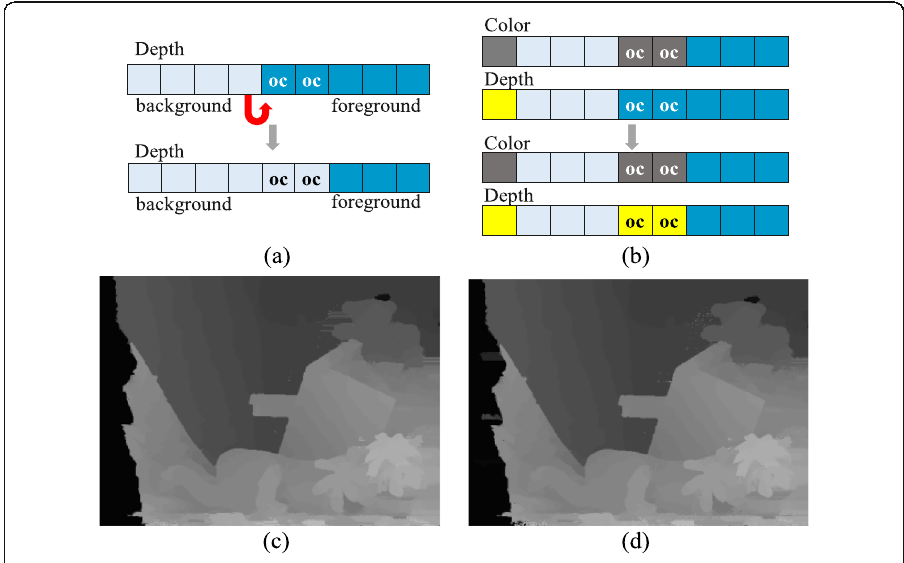
Fig. 12 Illustrations and results of the occlusion small-hole background filling methods. a Regular. b Matched-color. c Disparity map by regular. d Disparity map by